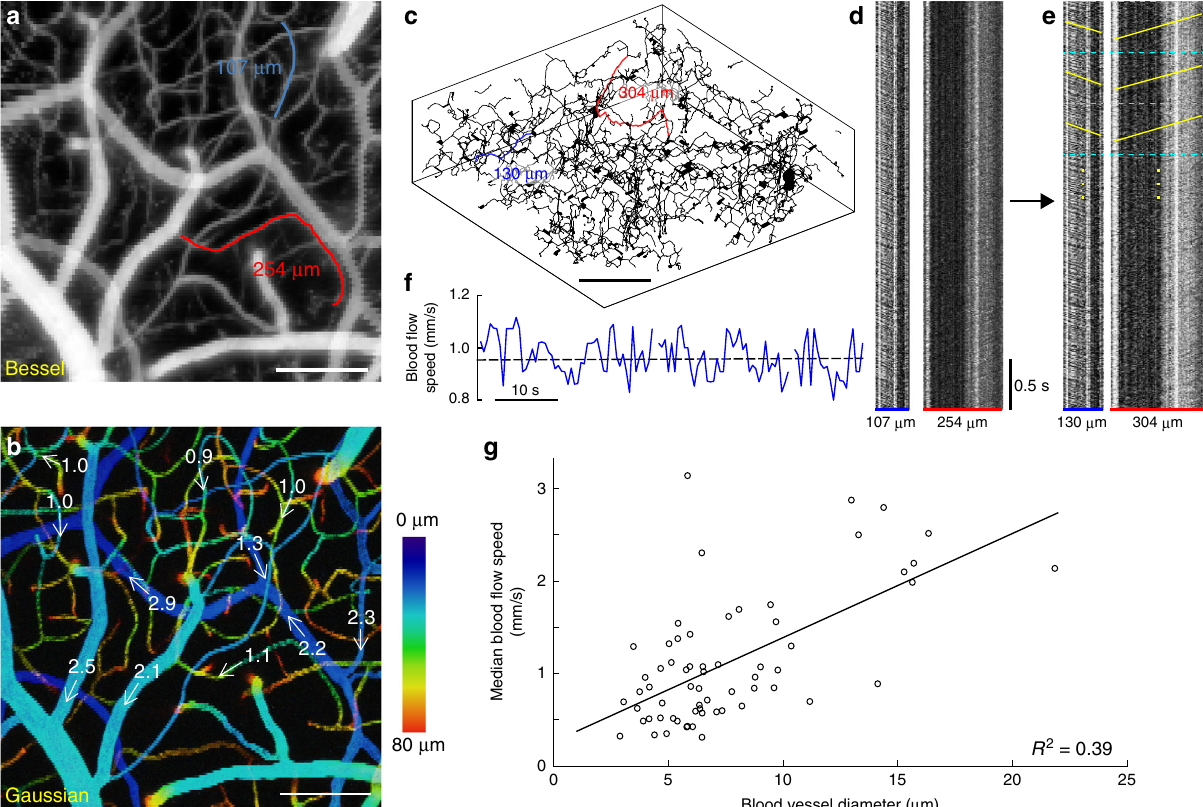
Fig. 5 High-speed volumetric measurement of cerebral blood fl ow speed with Bessel TPLSM. a Bessel image of a 416 µ m × 416 µ m × 80 µ m volume of vasculature that was imaged at 99 Hz with Bessel TPLSM for blood fl ow speed measurements, with structures visualized in grayscale on the normalized square root of fl uorescence signal. Blue and red lines trace two example vessel segments. b Gaussian image stack of the same volume in a , color-coded by depth and overlaid with median blood fl ow speeds (in mm/s) of 11 blood vessel segments. c Skeletonized 3D Gaussian stack from b for the measurements of blood vessel segment 3D lengths. d Kymographs of two example vessel segments in a , obtained by plotting pixels along the traced blood vessels (horizontal) across time (vertical). Dark diagonal streaks are caused by RBCs traveling along the vessel segment. Note that the horizontal axis represents projected 2D distance. e Kymographs of the same vessels after nonlinear transformation so that the horizontal axis represents 3D distance. For fl ow speed measurement, each kymograph was divided into 0.5-s-long blocks (cyan dashed lines, Methods). Yellow lines represent the distance – time relationship of the blood fl ow measured for each block. f Changes in blood fl ow speed over 1 min for the blue vessel segment in a . a – f : Representative data from eight volumes in four mice. g Median blood fl ow speed plotted against blood vessel diameter for 63 vessel segments between 0 and 180 µ m below dura, collected from four mice. Scale bars: 100 µ m for a – c . Post-objective power: Gaussian: 45 mW; Bessel: 217